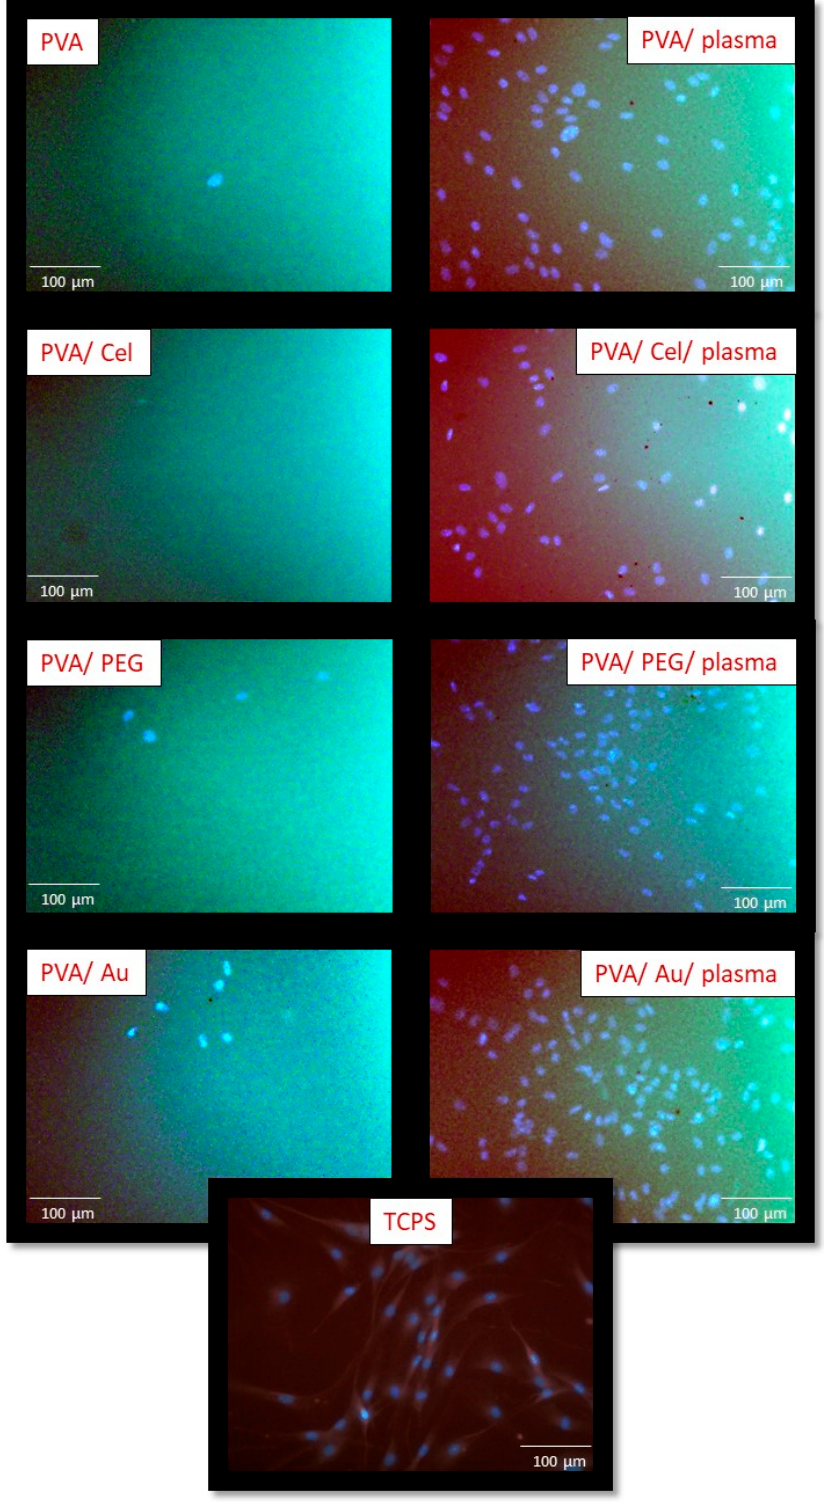
Figure 6. Fluorescence microscopy images of human ASCs on day 6 after seeding on untreated and plasma-treated PVA foils either non-doped or doped with cellulose (Cel), poly(ethylene glycol) (PEG) or with Au nanoparticles in PEG colloid solutions (Au), and on control tissue culture polystyrene (TCPS). Cell nuclei (blue) are stained with Hoechst 33258. All images have the same size and magnification.